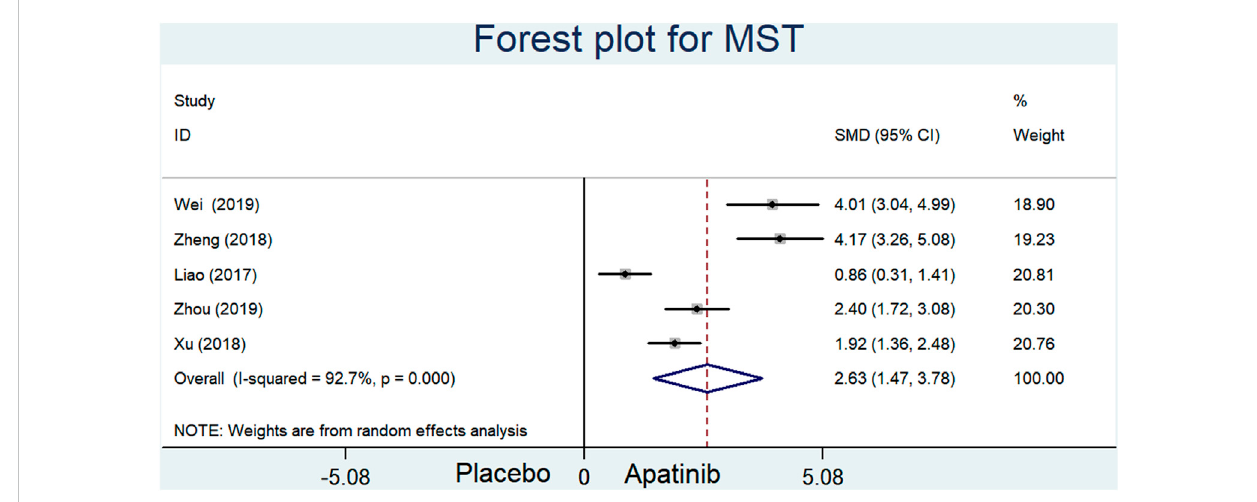
FIGURE 4 Forest plot for MST in included studies comparing apatinib with placebo.